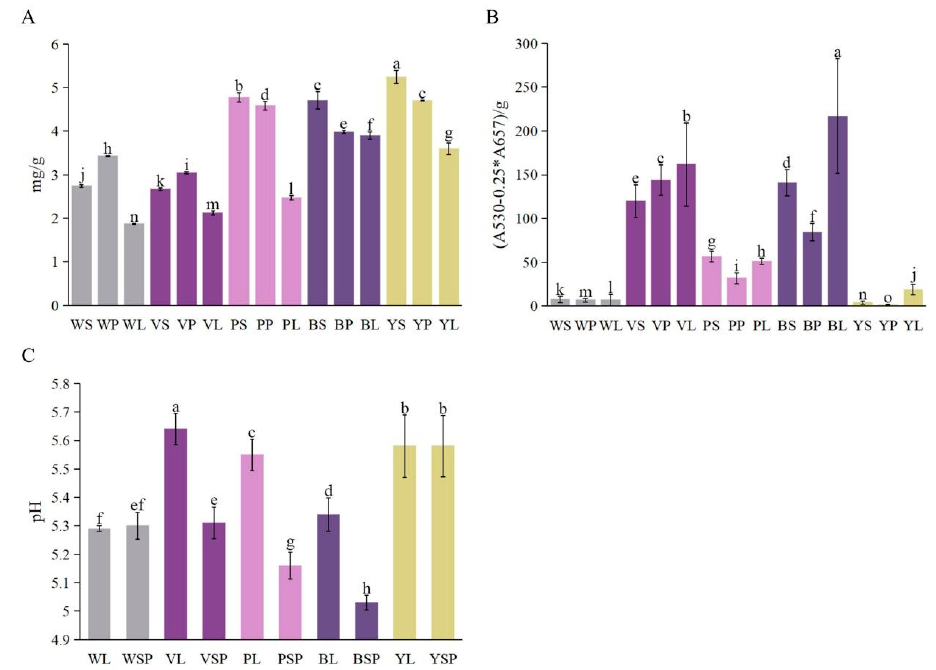
Figure 6. ( A ) Quantification of total flavonoids, ( B ) Determination of total anthocyanin, ( C ) pH in Bletilla . Error bars represent the standard error of the mean (SEM). Groups annotated with the same letter are not significantly different, according to LSD Test ( p < 0.05). WS: White sepal, WP: White petal, WL: White lip, VS: Violet sepal, VP: Violet petal, VL: Violet lip, PS: Pink sepal, PP: Pink petal, PL: Pink lip, BS: Blue sepal, BP: Blue petal, BL: Blue lip, YS: Yellow sepal, YP: Yellow petal, YL: Yellow lip, WSP: White perianth, VSP: Violet perianth, PSP: Pink perianth, BSP: Blue perianth, YSP: Yellow perianth.